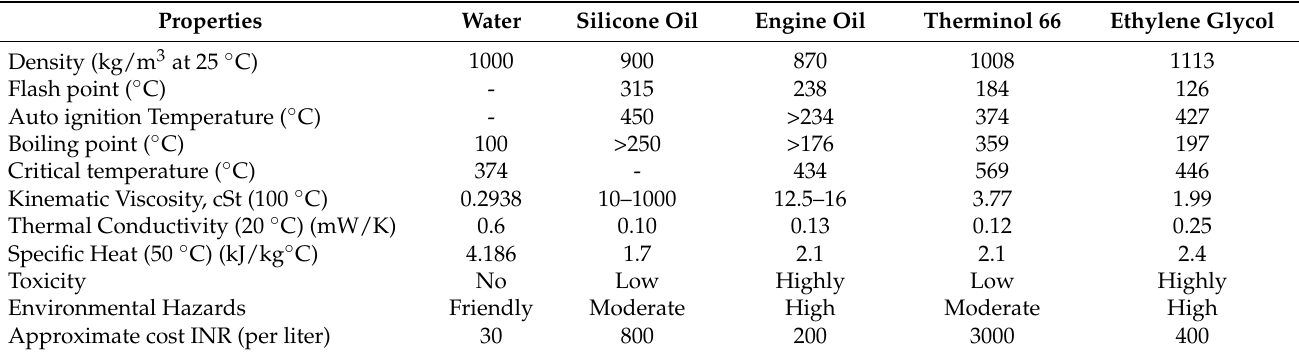
Table 3. Properties of heat transfer fluids